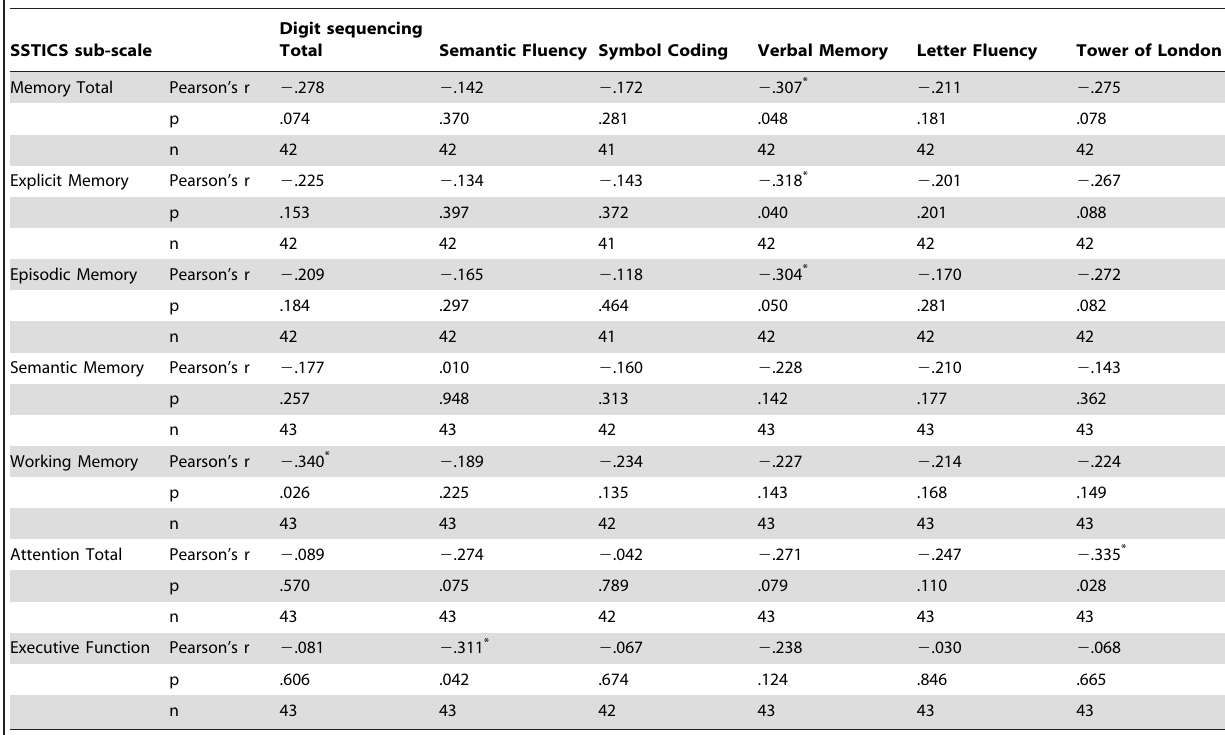
Table 3. Correlations between STICSS and BACS subscale scores in the non-patient group.